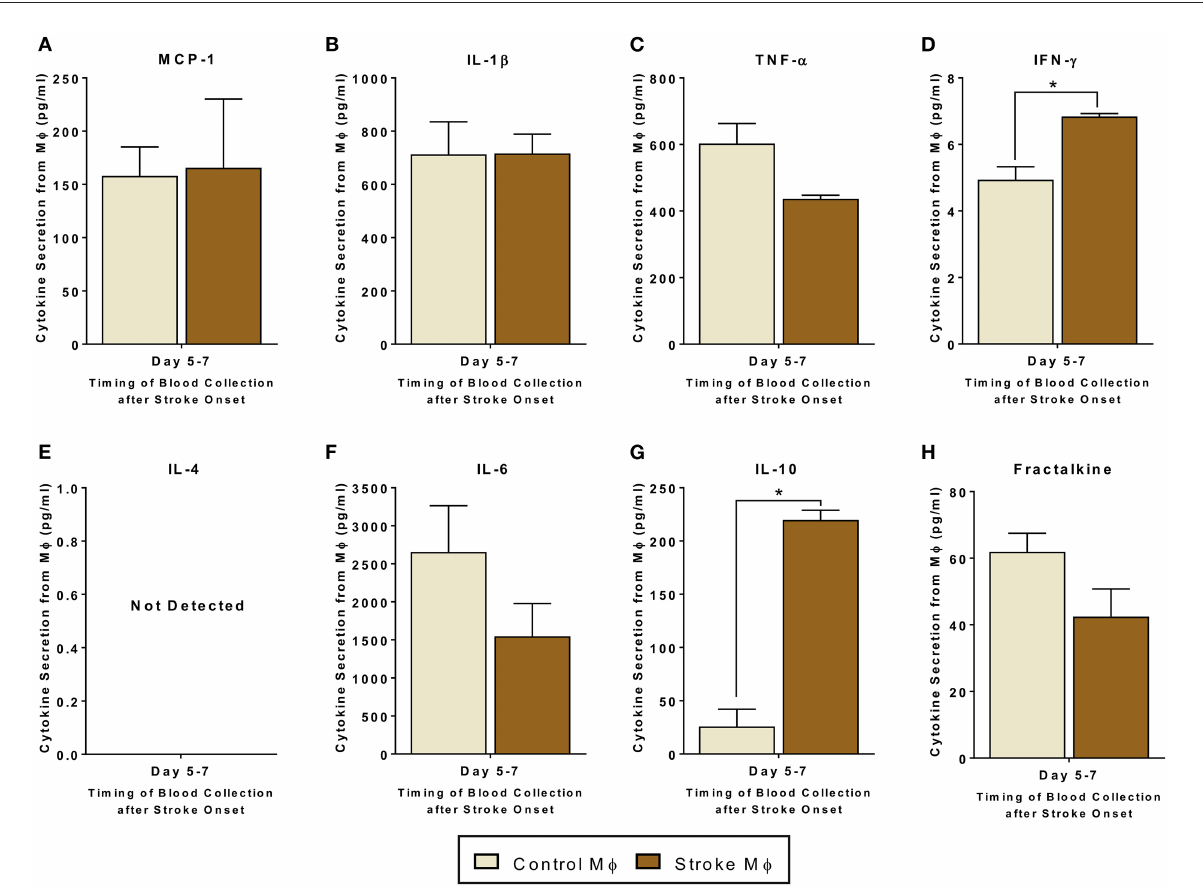
FIGURE1 Secretomes released from peripheral blood monocytes (M φ ). (A–H) represents secretions of MCP-1, IL-1 β , TNF- α , IFN- γ , IL-4, IL-6, IL-10, and Fractalkine. IL-4 secretions were not detectable. Monocytes are isolated from peripheral blood of healthy controls and stroke patients, and cultured alone for 24h ( N = 5, error bars represent SEM, * p <